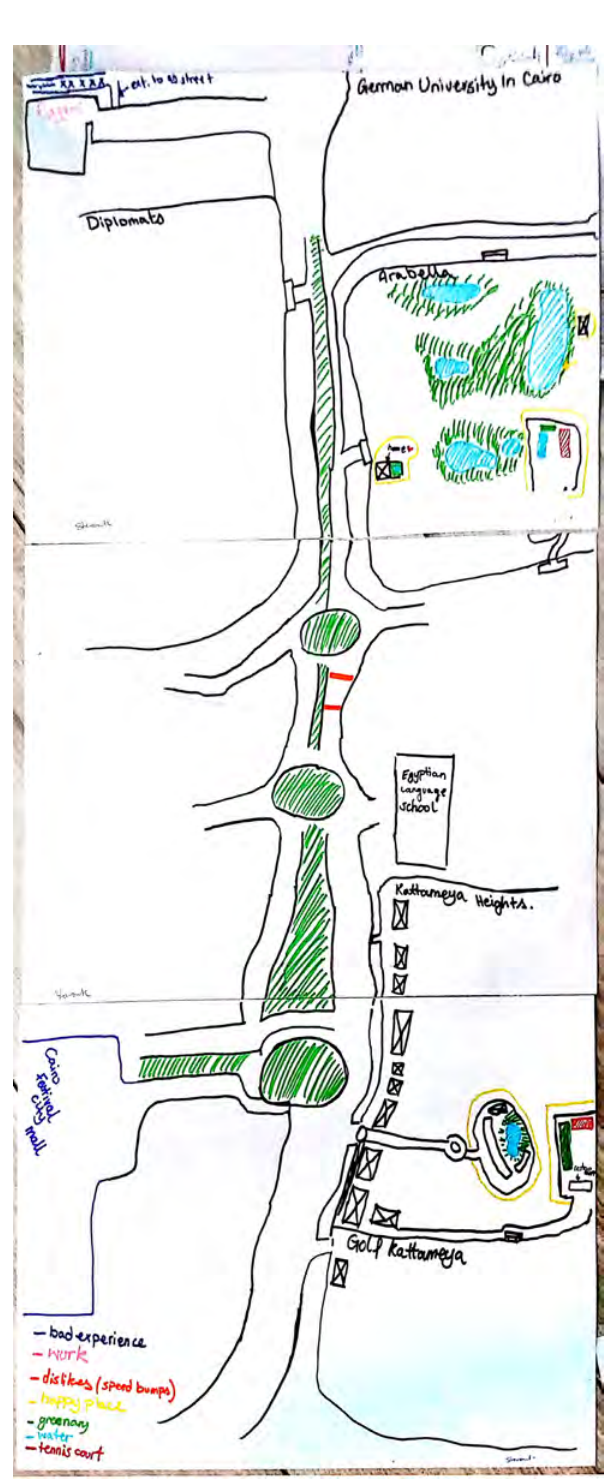
Figure 1. Sketch map of a gated residential area resident